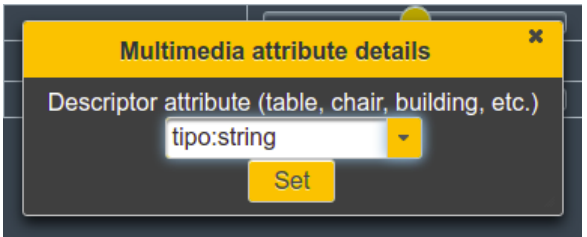
Figure 8. Selection of the attribute that describes the multimedia attribute.